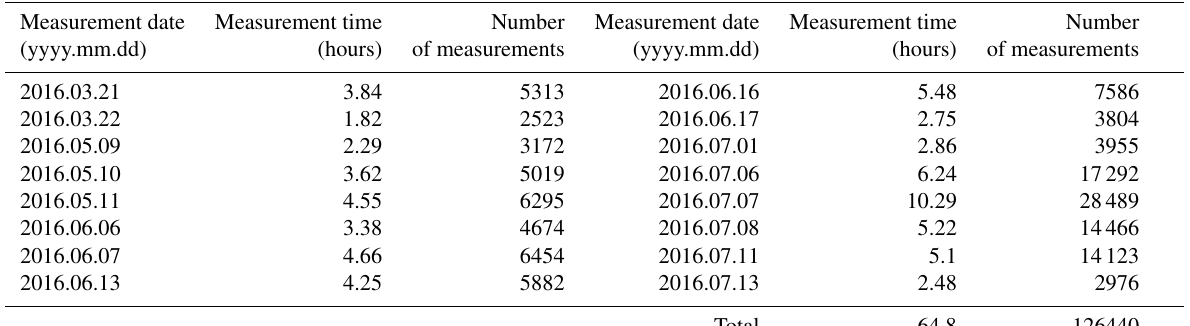
Table 1. Overview of the measurement days, time and number of measurements.